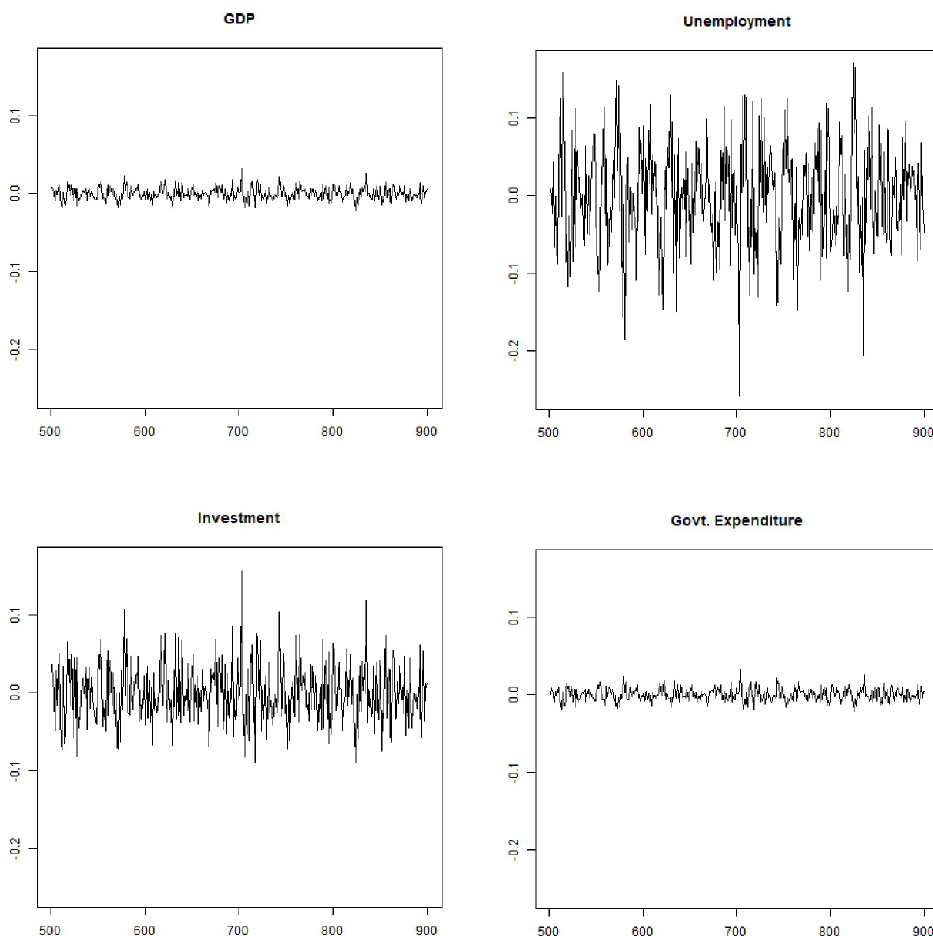
Fig 2. Cyclical components of simulated times series for GDP, unemployment, investment, and government expenditure. Source: Authors’ computations.